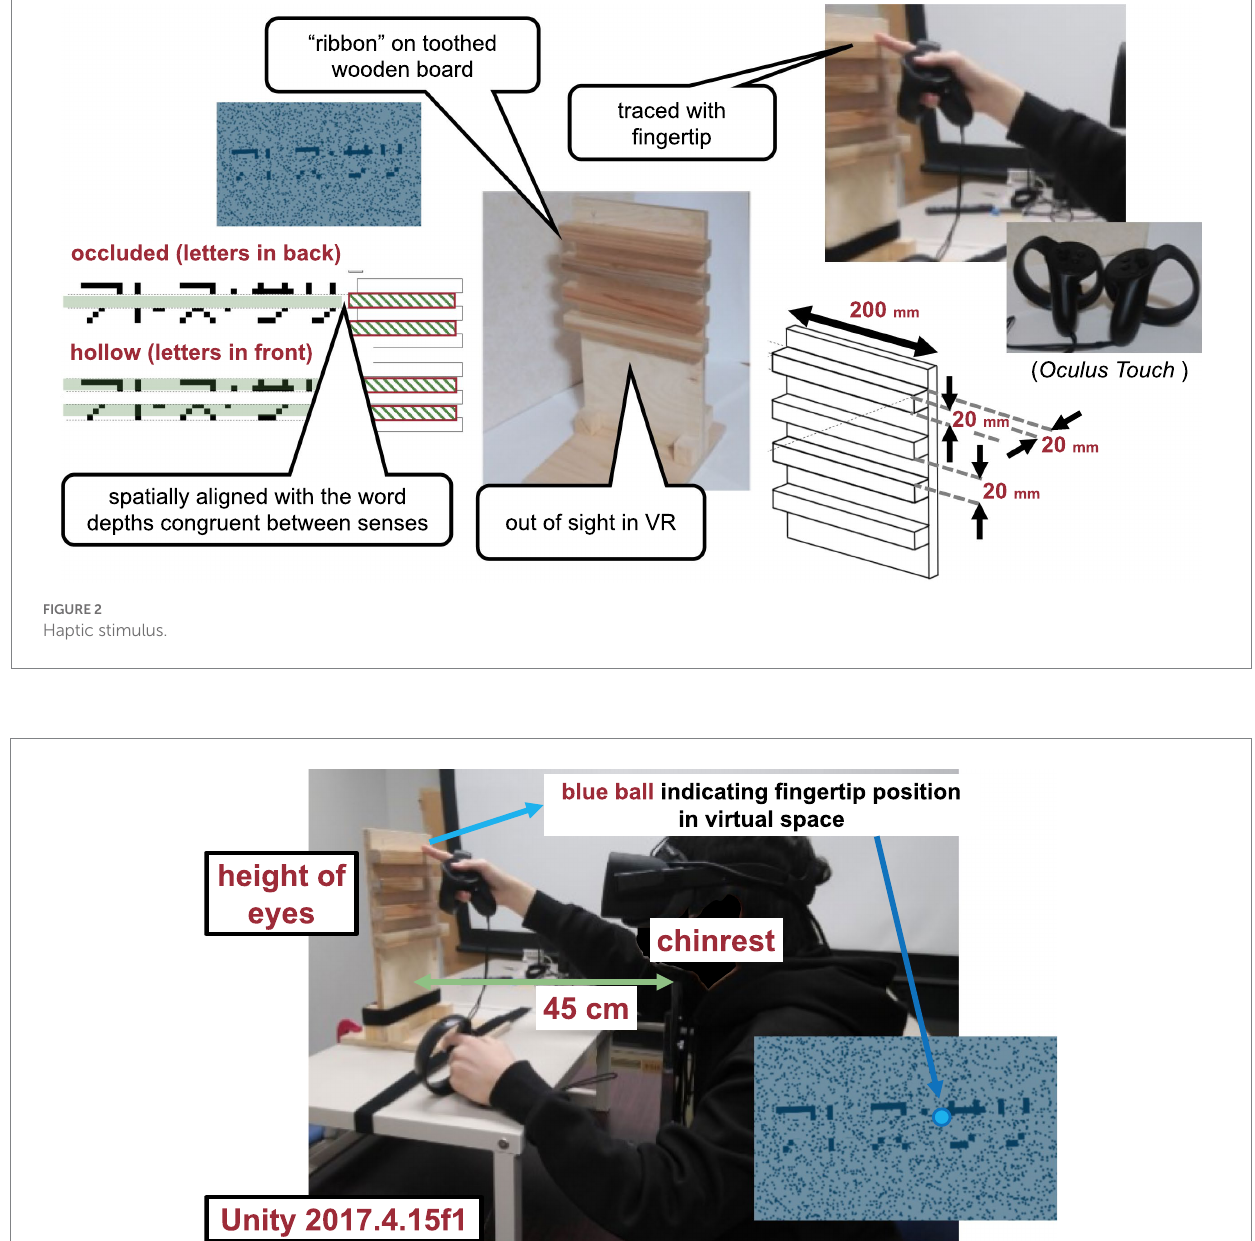
10 s. When the haptic cue was concurrent, the participants were additionally instructed to actively and concurrently trace one of the edges of the ribbon, but not the word, with the fingertip during the former 10 s period simultaneously with visual presentation. When the haptic cue was consecutive, a pair of red balls was first visually presented against a uniform gray background before the visual presentation of the word. The red balls indicate the positions of the ends of the edge in the VR space. The participants were instructed to actively trace the camouflaged edge with the fingertip for the first 5 s and were instructed to take the finger off the board during the following 10 s period for visual presentation. Thus, the edge was